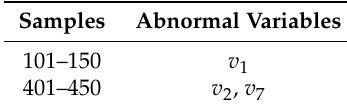
Figure 10. Fault detection results ( a ) after reconstructing v 2 , ( b ) after reconstructing v 2 and v 7 . Table 1. Results of Abnormal Variable Recognition.